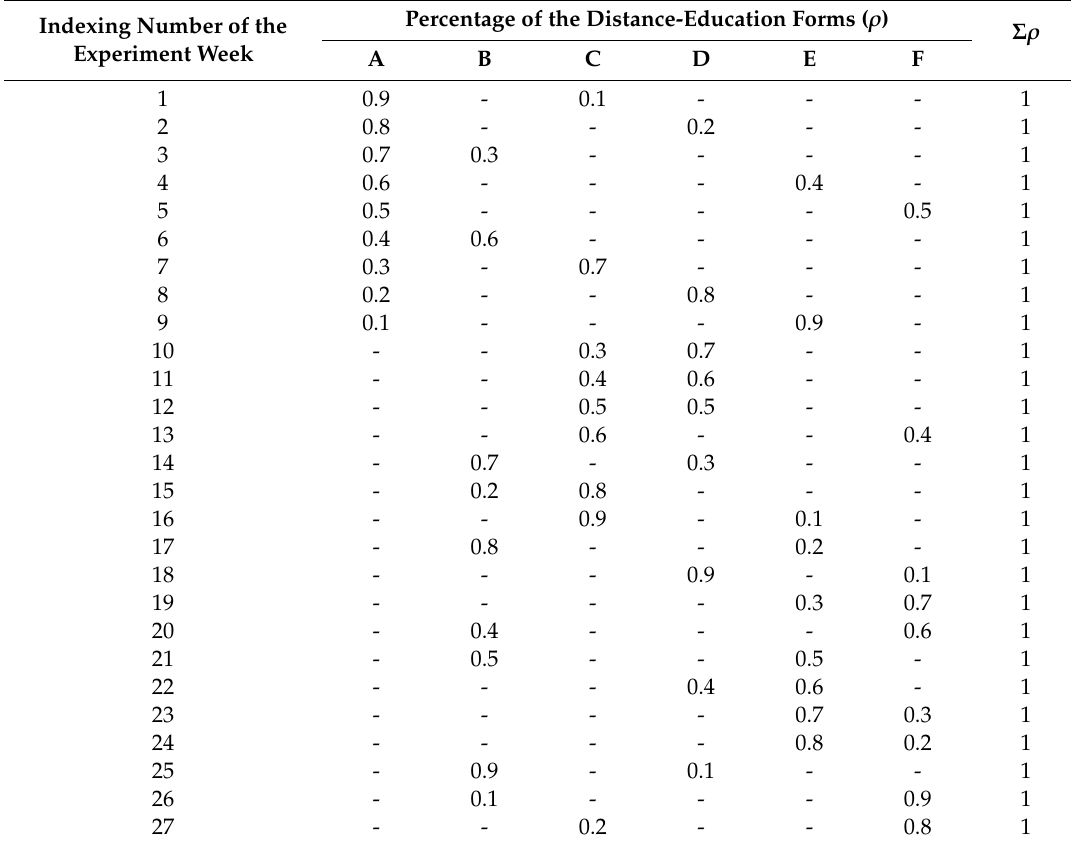
Table 1. Schedule for experimenting to improve the distance learning e ff ectiveness at the university: a case study of learning the discipline “Theoretical and Applied